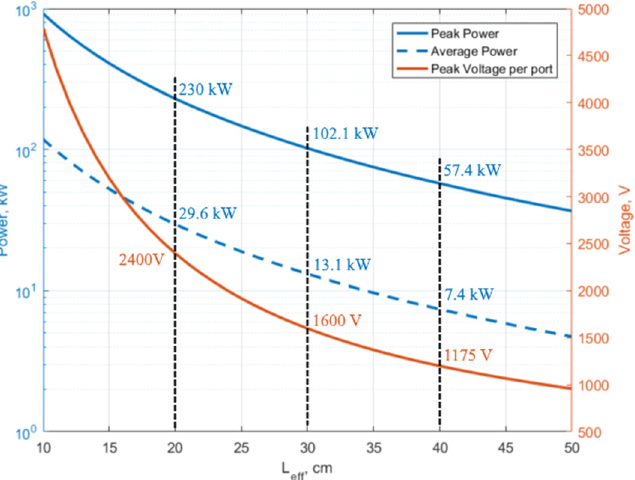
Figure 5. Required voltage and power consumption for 20 mrad deflection in the kicker with 14 mm gap.